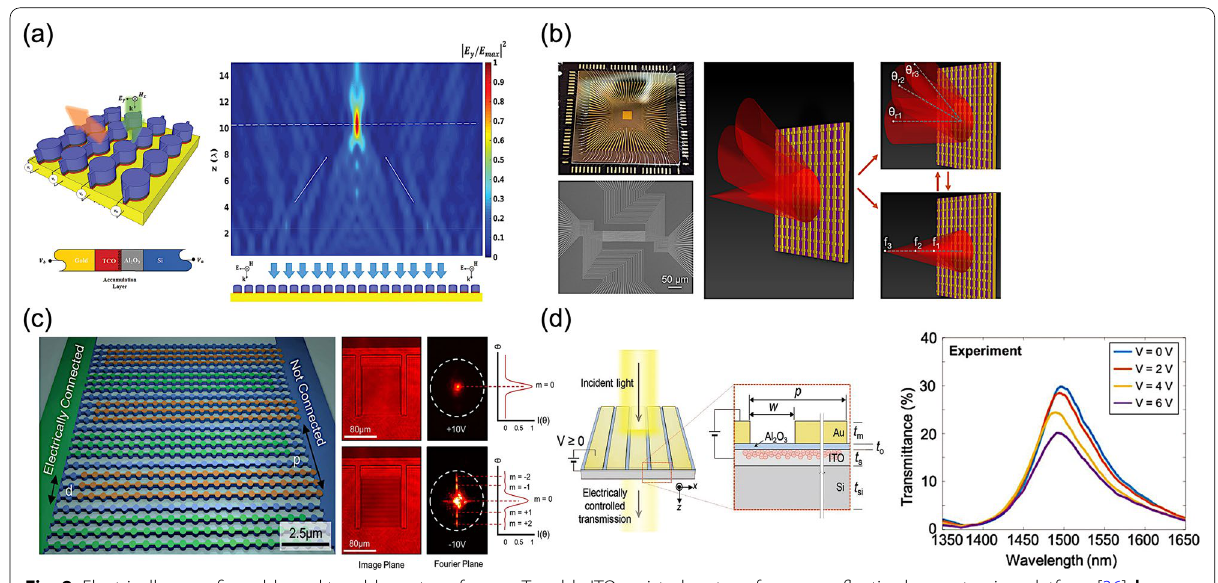
Fig. 8 Electrically reconfigurable and tunable metasurfaces a Tunable ITO‑assisted metasurface as a reflective beam steering platform [36], b Multifunctional metasurface with 96 independently addressable metasurface elements [37], c All‑dielectric Huygens metasurface for dynamic transmission control [38], and d Gate‑tunable metasurfaces for dynamic transmission control with hybrid plasmonic waveguide mode [39]